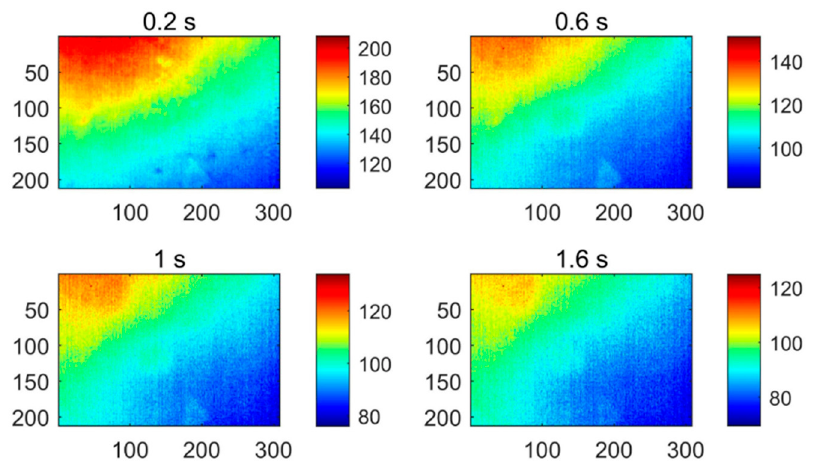
Figure 4. The PT thermograms of specimen 1 recorded at different sampling instances.